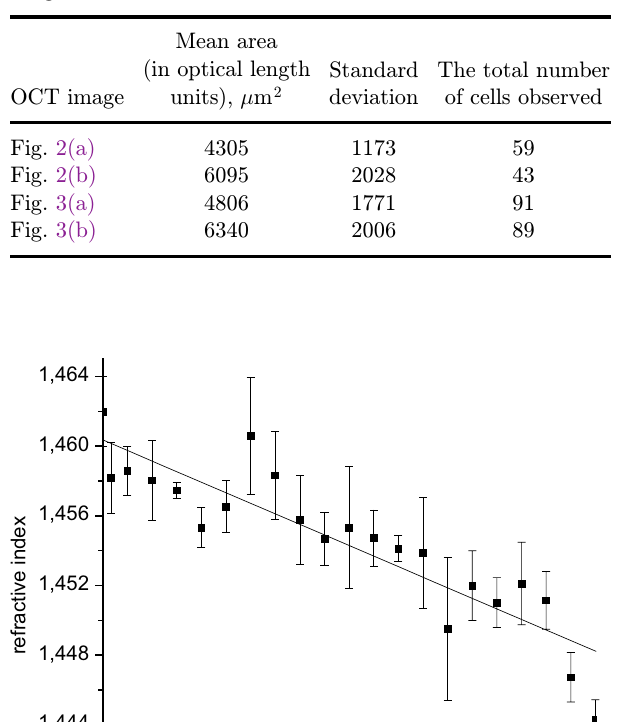
Table 1. Statistical analysis of light-induced changes in cell image area.